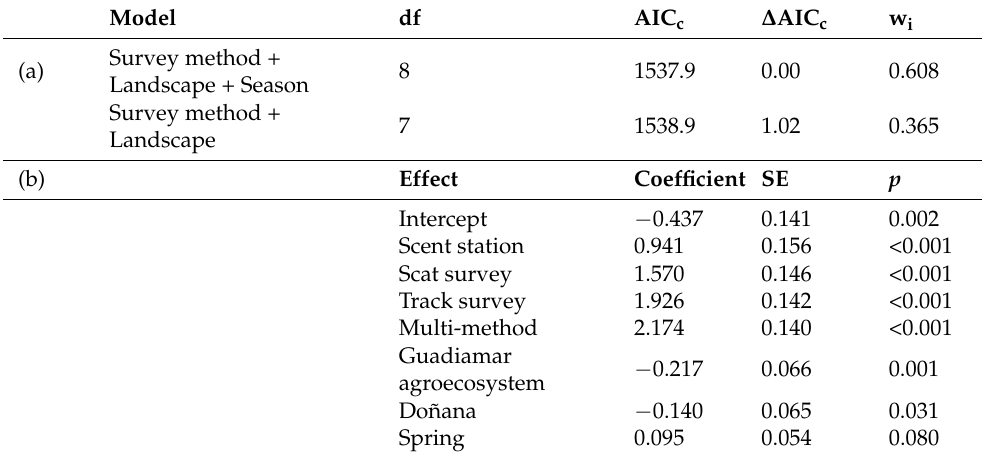
Table 2. Effect of survey method on species richness. (a) Competitive generalised linear models ( ∆ AIC c ≤ 2) ordered by the fit statistic AIC c . Models differ in the external factors that are controlled for, i.e., sampling season and landscape. (b) Parameter estimates of the resulting averaged model. The method ‘Camera trap’, the season ‘Autumn’, and the landscape ‘Sierra Morena’ are included in the intercept. AIC c : corrected Akaike Information Criterion; w i : Akaike